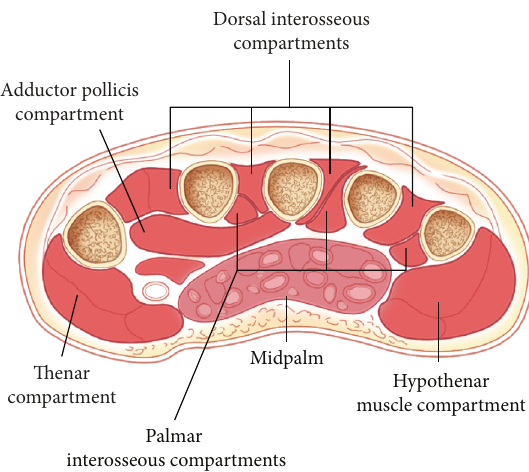
Figure 1: The eleven compartments of the hand [12].